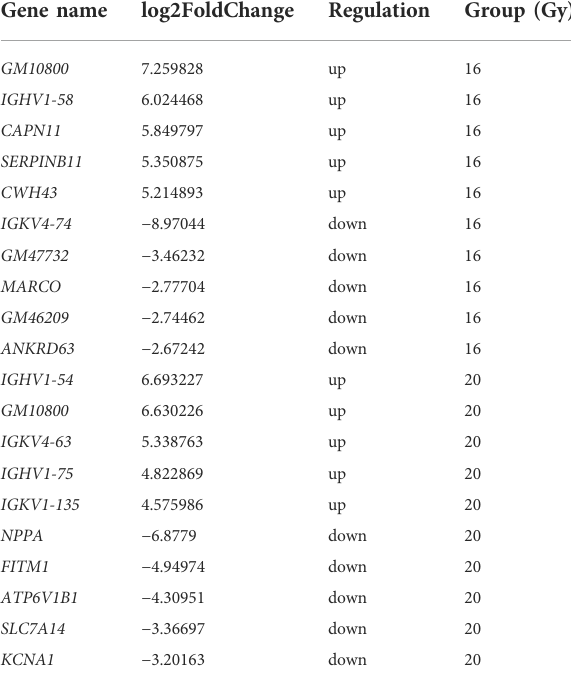
TABLE 1 Top 5 Signi fi cantly Up and Downregulated mRNAs in the radiation groups at 3 months.